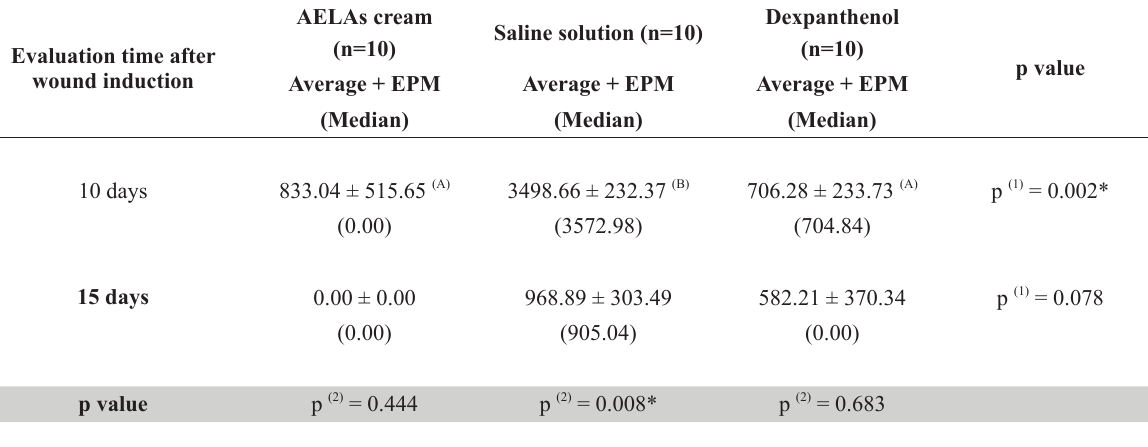
Distance between the epithelia of the surgical wound of the groups in relation to the evaluation time after in vivo surgical